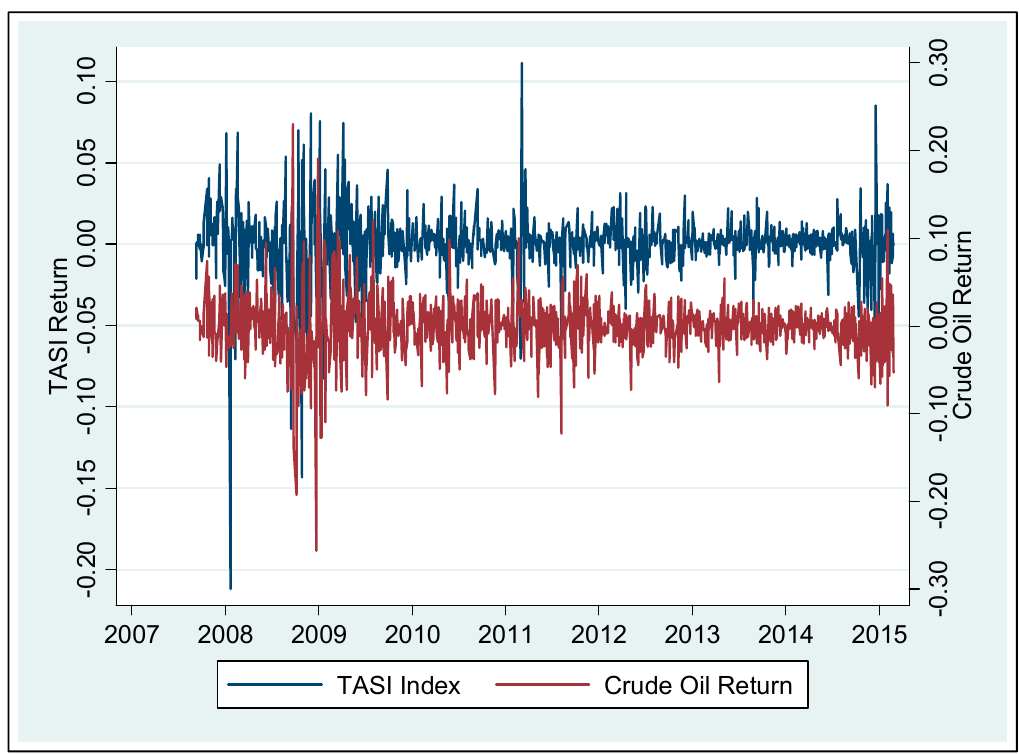
Figure 1. Daily returns for the TASI index and oil prices during the period from January 2007 to February 2015.